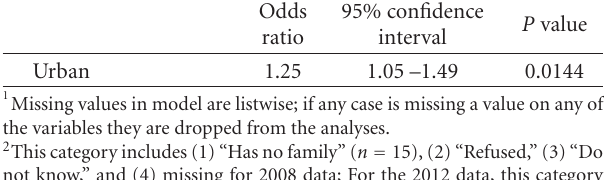
Table 2: Independent correlates of awareness of direct-to-con- sumer (DTC) genetic testing ( n = 10,394) 1